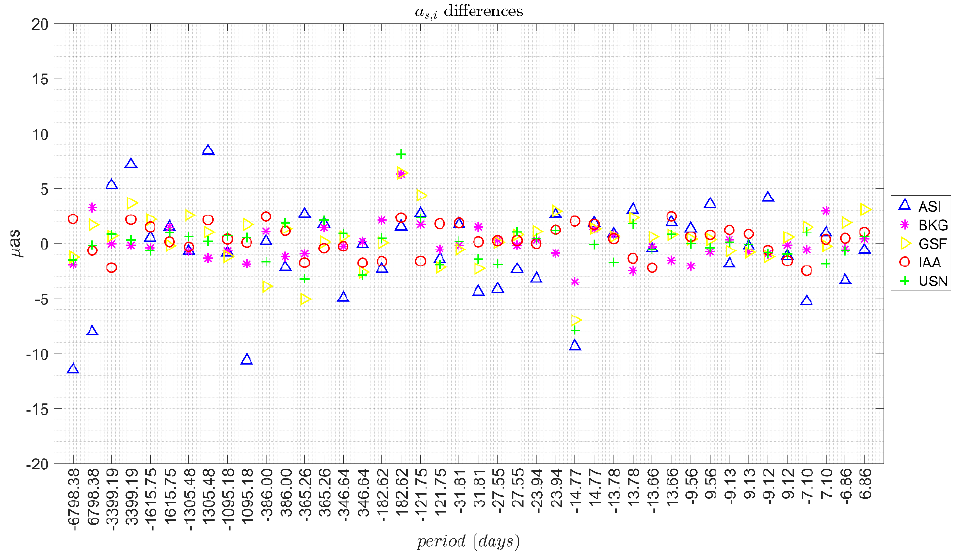
Figure 2. Differences in a s , i terms derived from the ICRF3 and ICRF2 series.